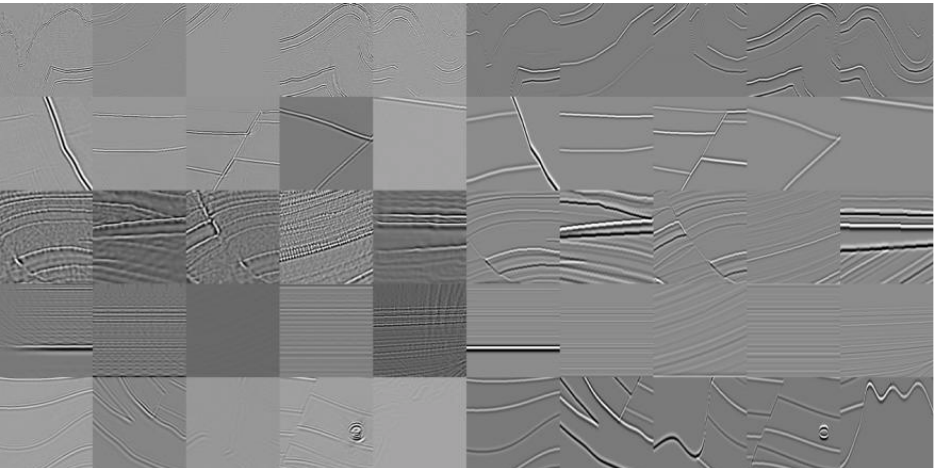
Figure 4. The image pairs “AB” for training. The images on the left are the seismic images “A”, and the images on the right are the reflectivity images “B”. The “A” images were derived through the RTM migration technique, and the “B” images were derived through the precise velocity model.